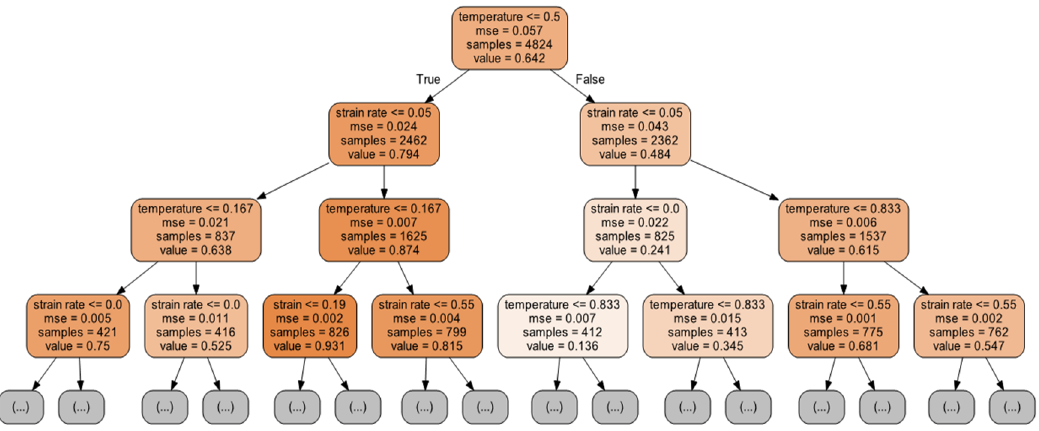
Figure 10. Decision tree for the current model.